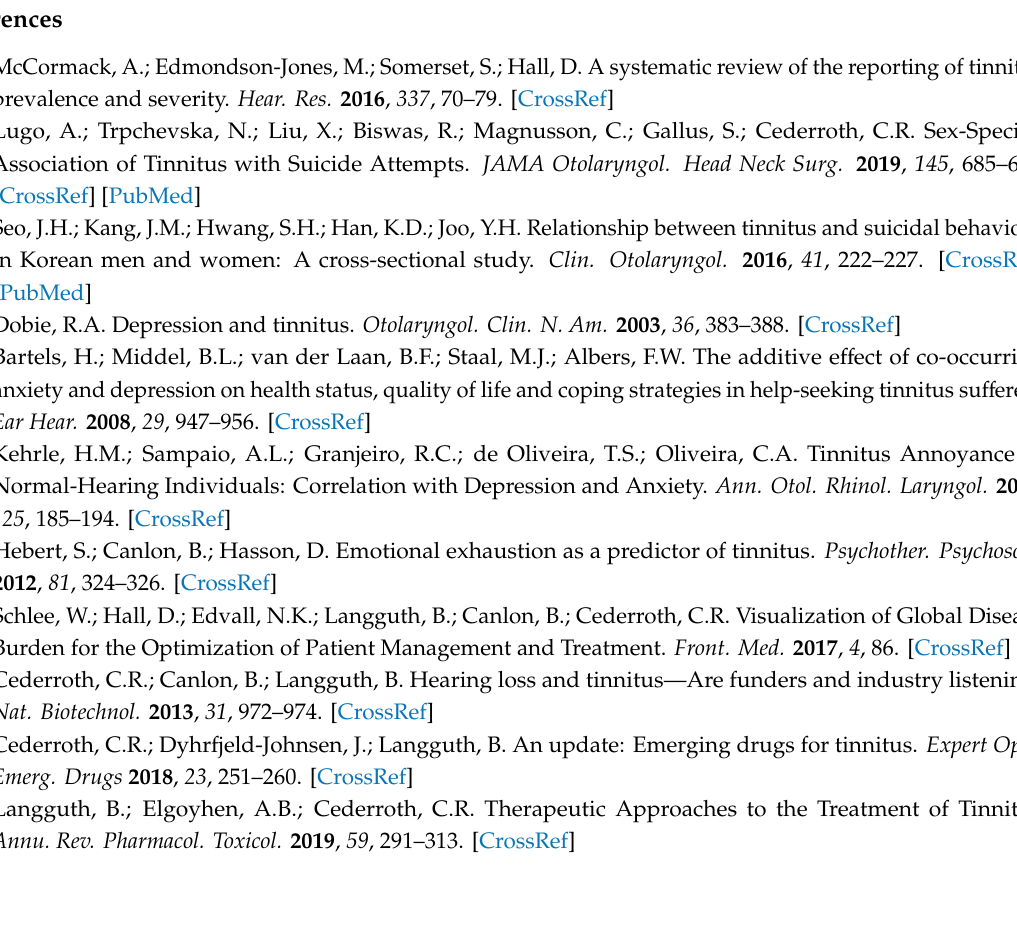
s1, Table S1: Sex stratified analysis of sociodemographics, Table S2: Sociodemographic and psychological characteristics for participants with tinnitus with or without hyperacusis, Table S3: Questionnaire scores from participants with tinnitus with or without hyperacusis, Table S4: Phenotypic characteristics for participants with tinnitus with or without hyperacusis, Table S5: Comorbidities in participants with tinnitus with or without